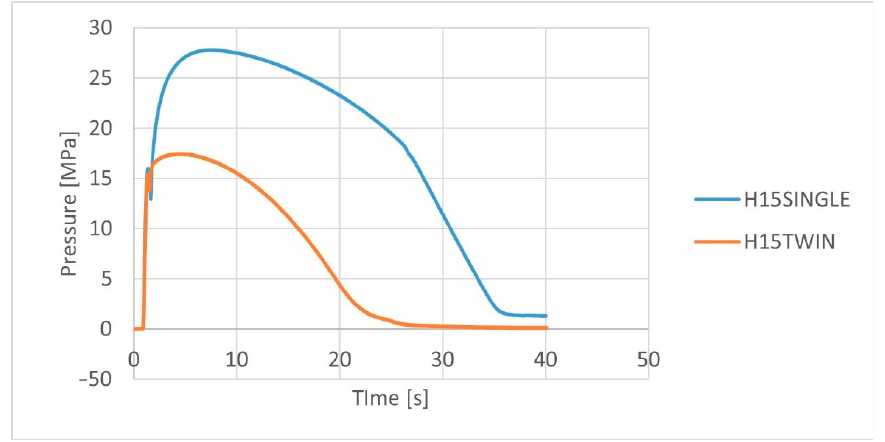
Figure 5. Variation of the cavity pressure for PHBV biocomposites with hemp fibers extruded by various methods.